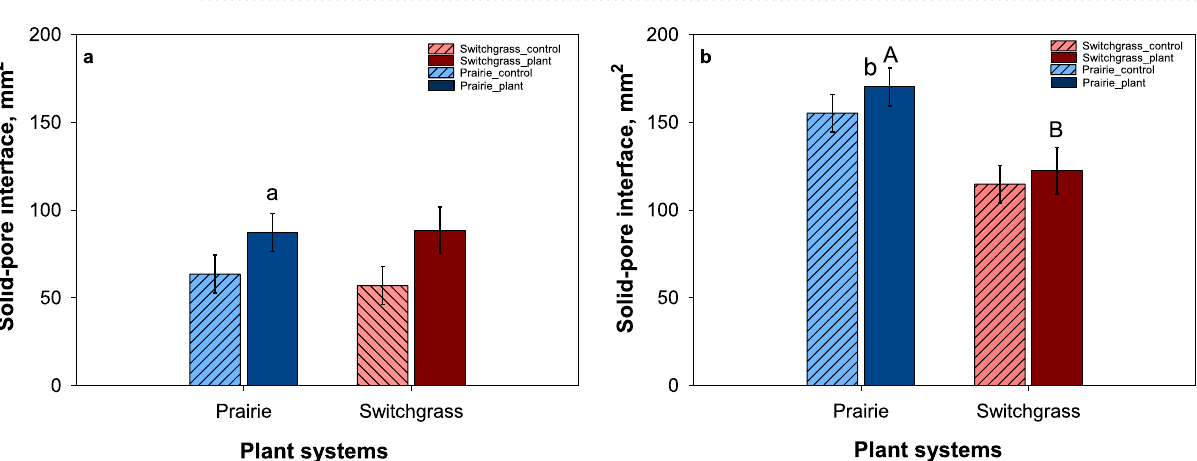
Figure 6. Pore size distribution for image-based (> 18.2 μm) pores for depression ( a ) and slope ( b ) in the control cores (solid lines) and in plant grown cores (dash lines) in prairie ( ▼ ) and switchgrass ( ● ) cropping systems. Shown are means with error bars representing standard errors (n = 3). Lower case letters indicate significant differences between topographical positions within each system for plant-grown cores (p < 0.05); upper case letters indicate significant differences between cropping systems within each topographical position for plant-grown cores (p < 0.05).